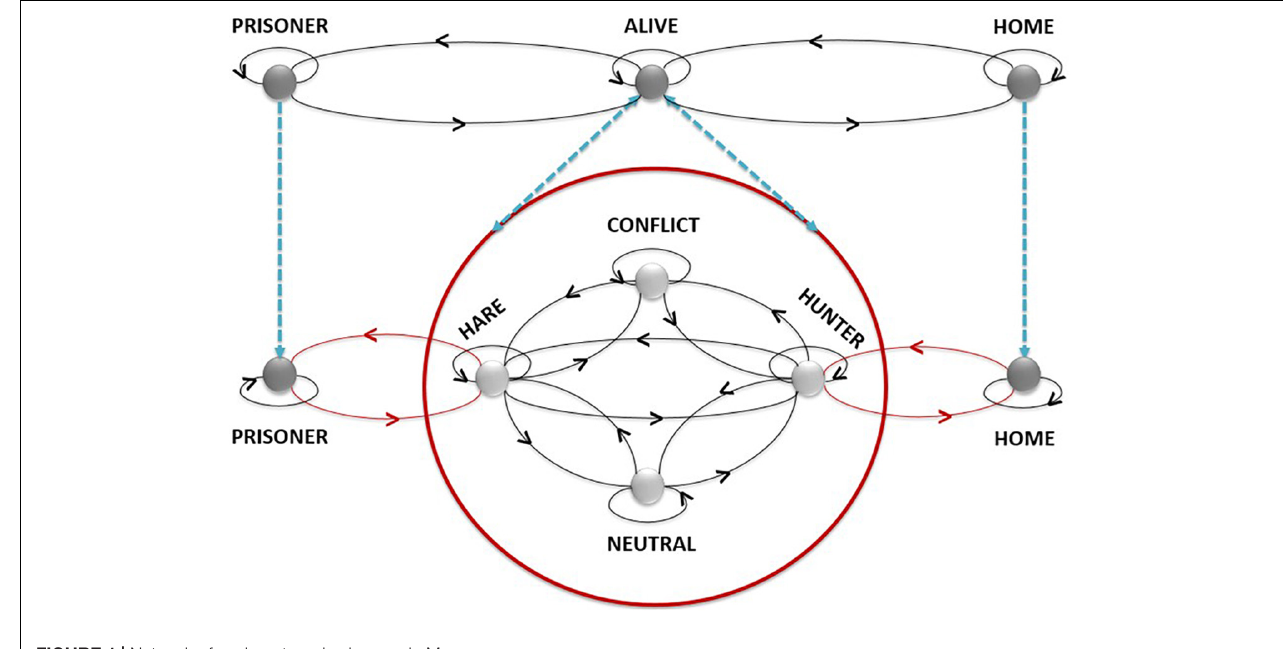
FIGURE 1 | Network of sociomotor role changes in Marro.